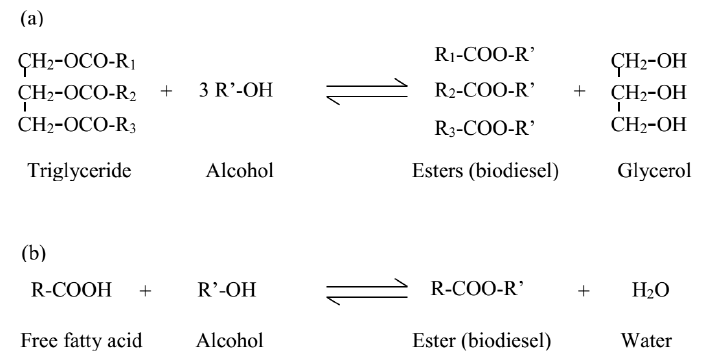
Figure 1. Mechanism of the “transesterification-route”: ( a ) transesterification reaction between triglyceride and alcohol to produce esters and glycerol; ( b ) esterification of free-fatty-acid (FFA), and alcohol to produce ester and water.